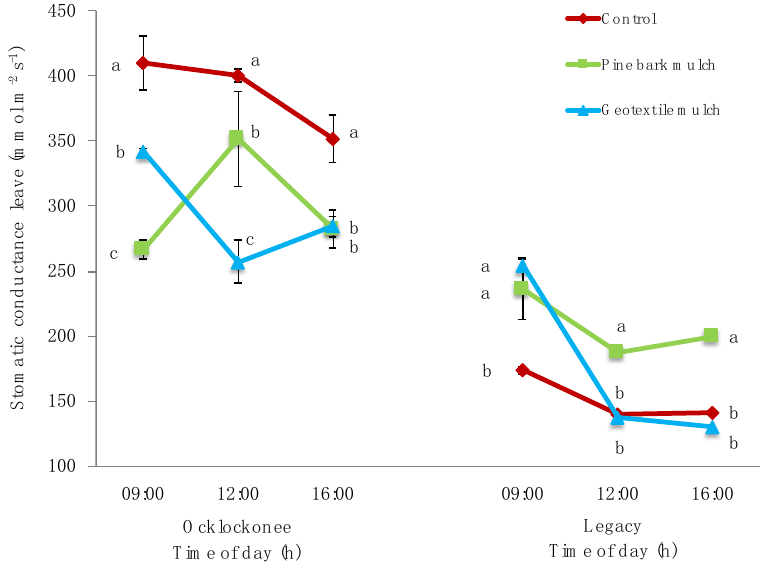
Figure 3. Effects of the different types of mulch on the stomatal conductance in leaves (mmol m − 2 s − 1 ) at three times of the day. For each different the time of day, lowercase letters indicate significant differences for different types of mulch, according to the Tukey test ( p < 0.05). The vertical bars correspond to ± the standard error of the mean ( n = 9).